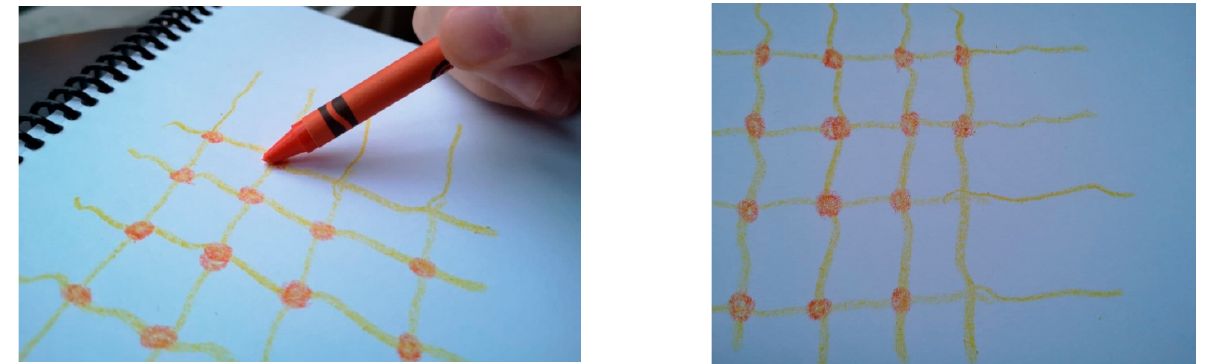
Figure 11. An example of gradual increase in the number of points.